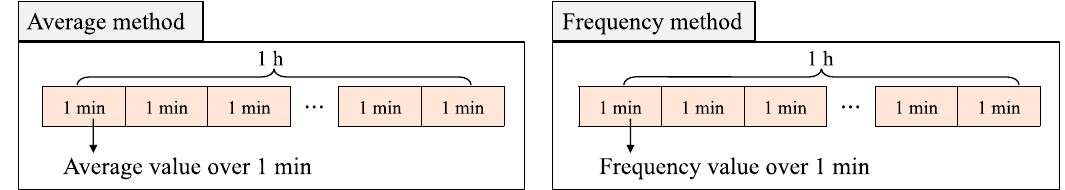
Figure 6. Methods for the development of the activity-decision algorithm.